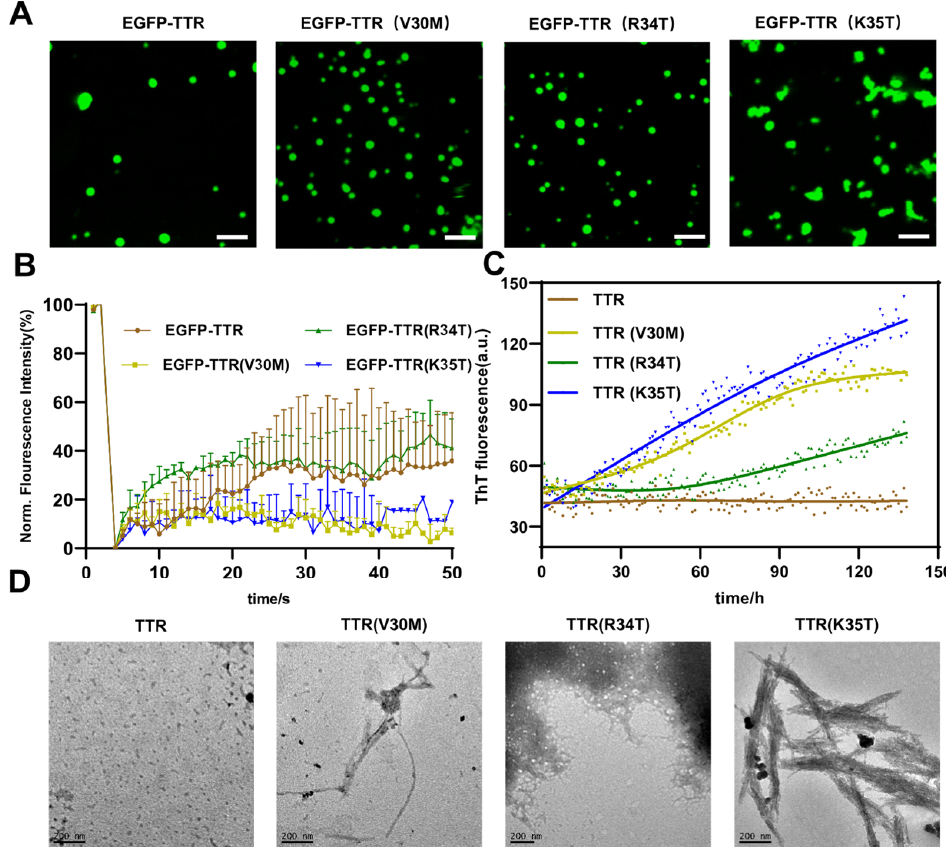
Figure 3. Disease-associated mutations accelerate TTR droplets maturation and aging into fibrils. ( A ) Confocal microscope images of 10 µ M EGFP-TTR and disease-associated mutants (V30M, R34T, K35T) with an EGFP fusion label at pH 5.5. Scale bar, 2.5 μ m. ( B ) FRAP of 10 μ M EGFP-TTR and disease- associated mutants (V30M, R34T, and K35T) at pH 5.5. Error bars represented SEM (n = 3). ( C ) The ThT fluorescence intensity was measured for 40 µ M TTR and disease- associated mutants (V30M, R34T, K35T) at pH 5.5, 37 °C. Error bars represented SEM (n = 3). ( D ) TEM imaging of fibrillar aggregates formed from 40 µ M TTR and disease- associated mutants (V30M, R34T, and K35T) at pH 5.5, 37 °C. Scale bar, 200 nm.